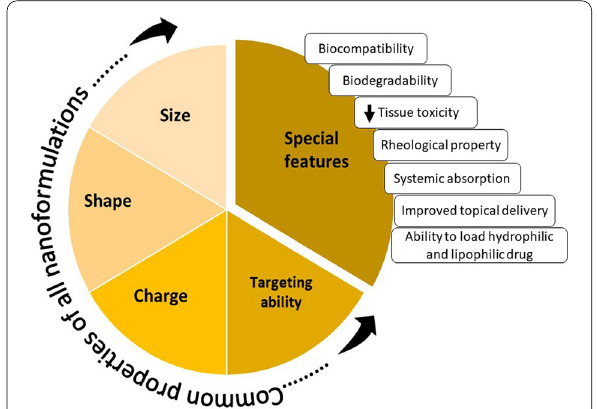
Fig. 1 Critical features of liposome-based cosmeceutical formulations